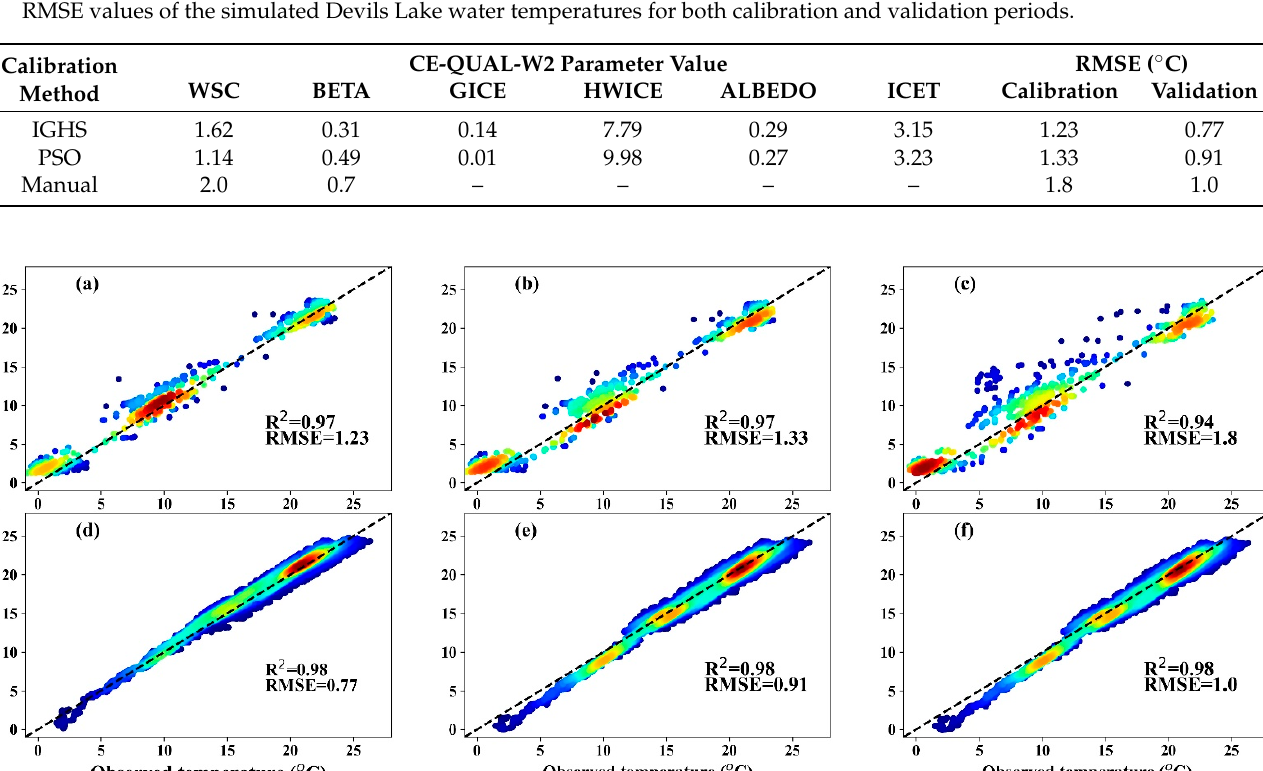
Figure 6. ( a – f ) Left panel and ( g – l ) right panel show the CE-QUAL-W2 parameter values for IGHS and PSO solutions, respectively. Black dots show the optimal values for the CE-QUAL-W2 parameters. CV is the coefficient of variation, and its higher value means larger variation from the calculated mean.